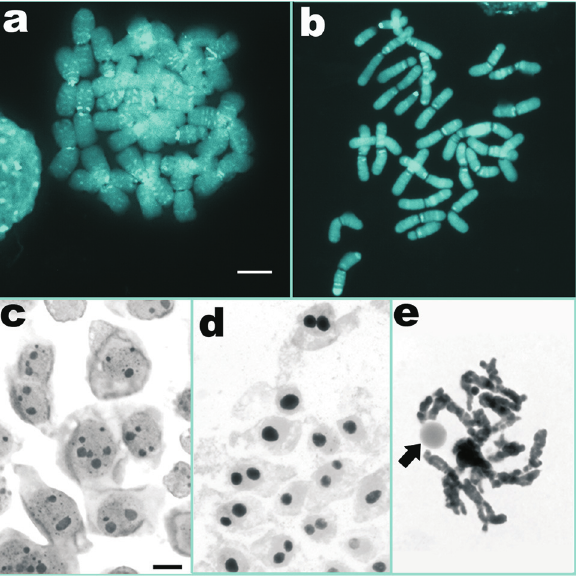
Figure 4 - Heterochromatic bands observed after FISH (a, b) and nucleoli (c-e) in C. monogyna (a, c) and C. indecora (b, d, e). Arrow in (e) points to the single nucleolus of a diplotene. Bar in (a) and (c) corresponds to 10 (cid:3)